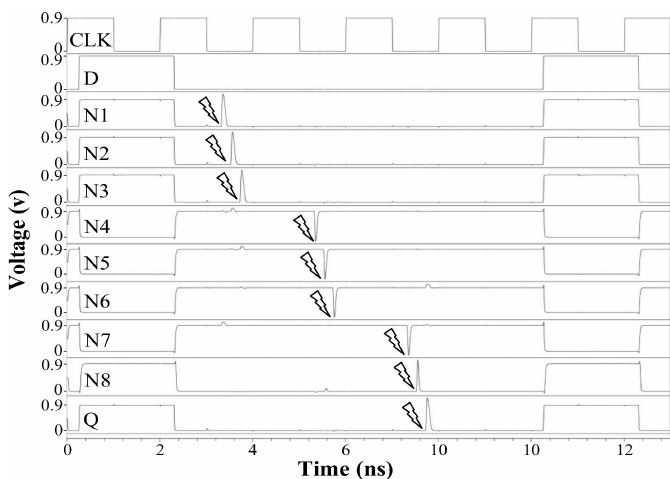
Figure 11. Simulation for SNU injections of HTNURL latch.